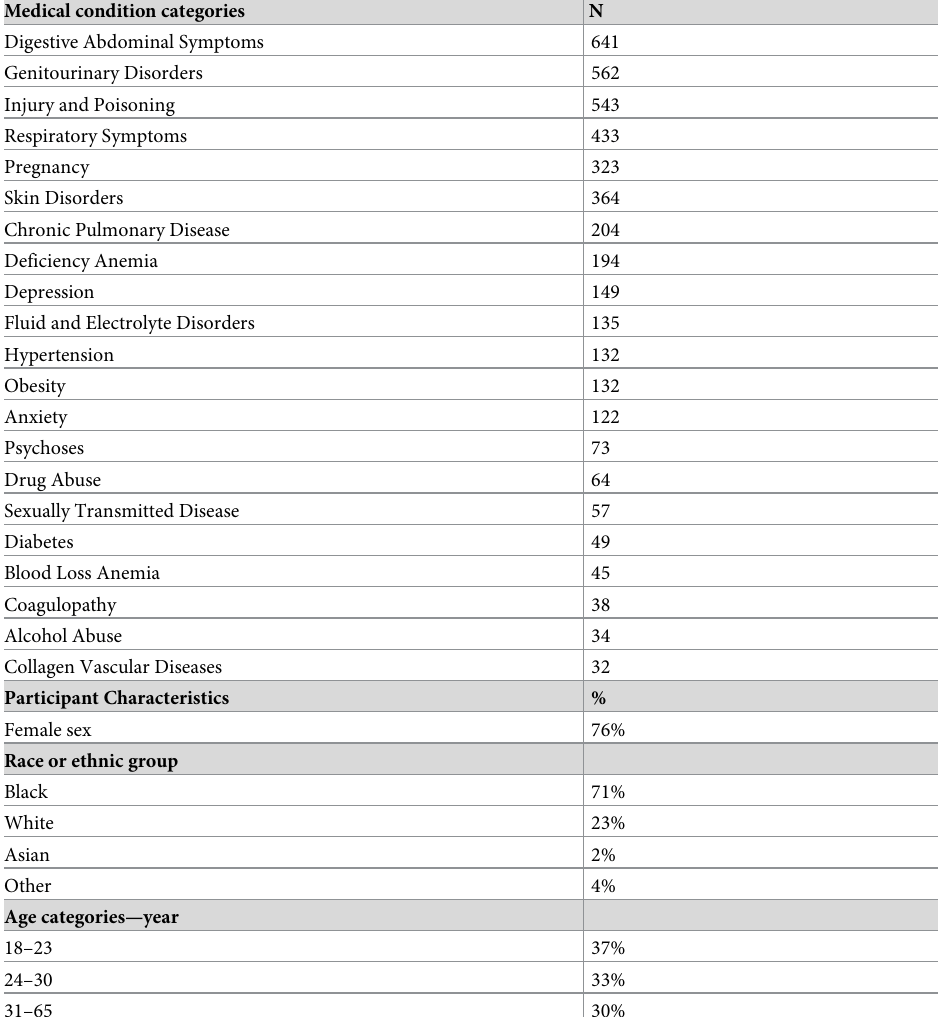
Table 1. Medical condition prevalence and participant